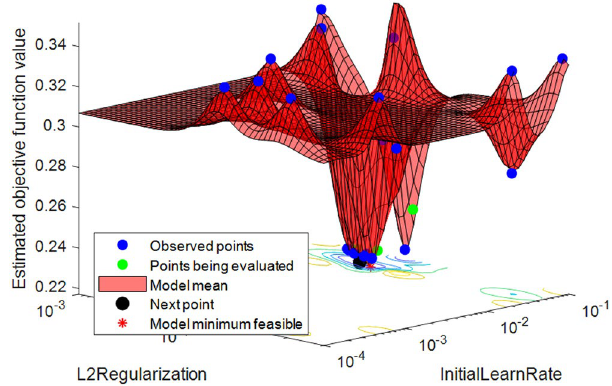
Figure 3. Determining the best feasible hyper-parameters of LSTM network using Bayesian